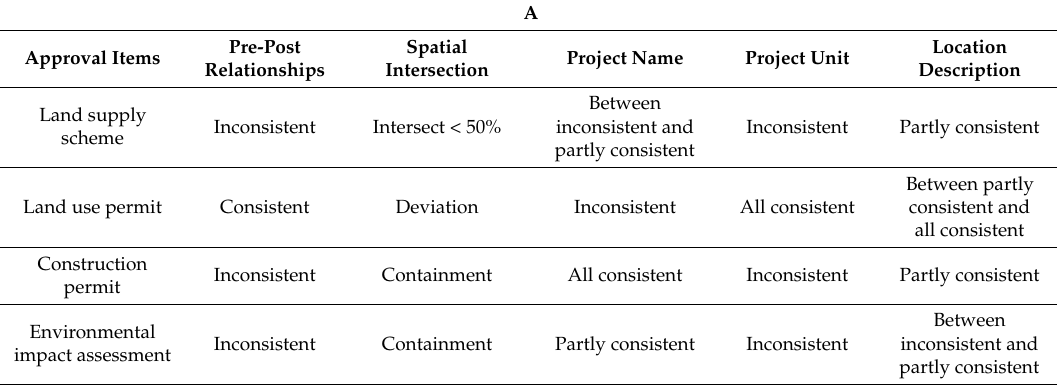
correlation among the factors of construction project B.